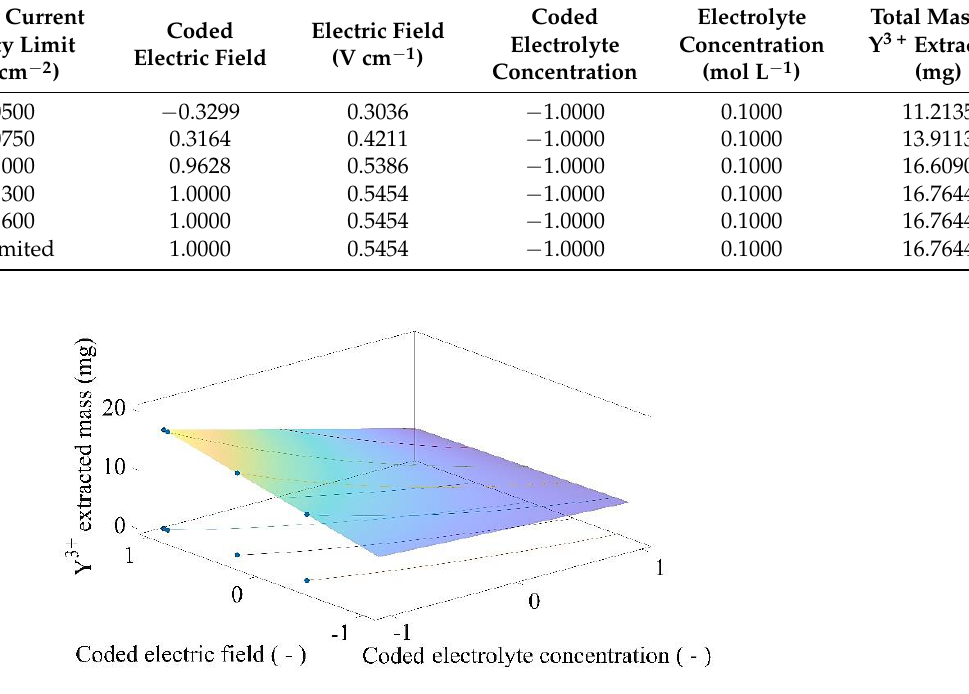
Figure 6. Extracted mass function considering the coded design variables containing the representations of the limit electric current density isolines.